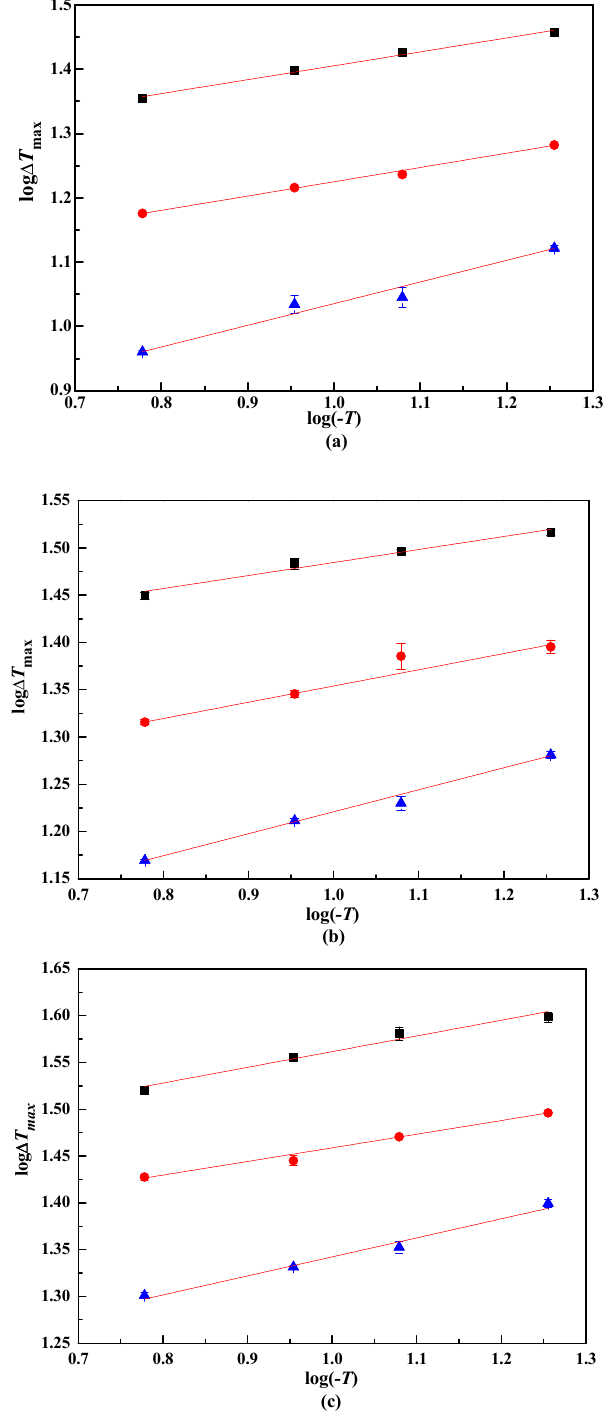
Figure 4. log ∆ T max and log( − T ) in NaCl solutions. (cid:4) , 323.15 K. • , 313.15 K. (cid:78) , 303.15 K. NaCl (100 w ): Figure 4. log Δ T max and log( − T ) in NaCl solutions. ■ , 323.15 K. ● , 313.15 K. ▲ , 303.15 K. NaCl (100 w ): ( a ), 0.00. ( b ), 4.47. ( c ): ( a ), 0.00. ( b ), 4.47. ( c ): 10.31. For MZW data using the laser technique in the pure system LiBO 2 − H 2 O, B calculated from Equation (5) is 0.2503, and m of lithium metaborate salts is 4.00. The presence of NaCl impurity enlarged the apparent secondary nucleation order. With w (NaCl) = 0.447 in the solution, the m of